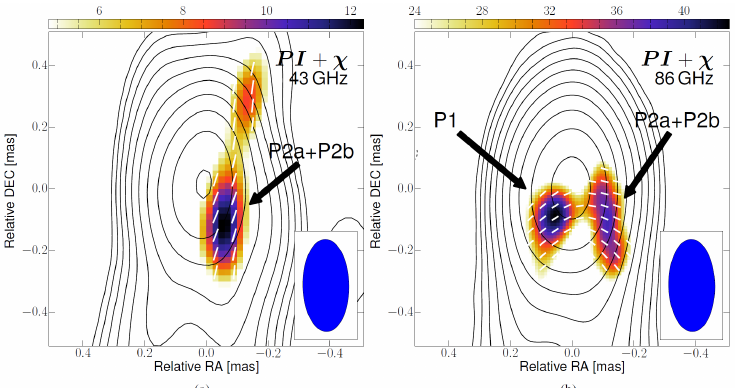
Figure 6. Linear polarization images of the 3C 84 jet observed with the VLBA at 43 GHz ( left ) and with the GMVA at 86 GHz ( right ), taken from Kim et al. [132]. The images were obtained quasi- simultaneously in May 2015 and convolved with the same beam. The contours represent the total intensity distributions. The colors show the linearly polarized intensity distributions, and the white ticks are the EVPAs.